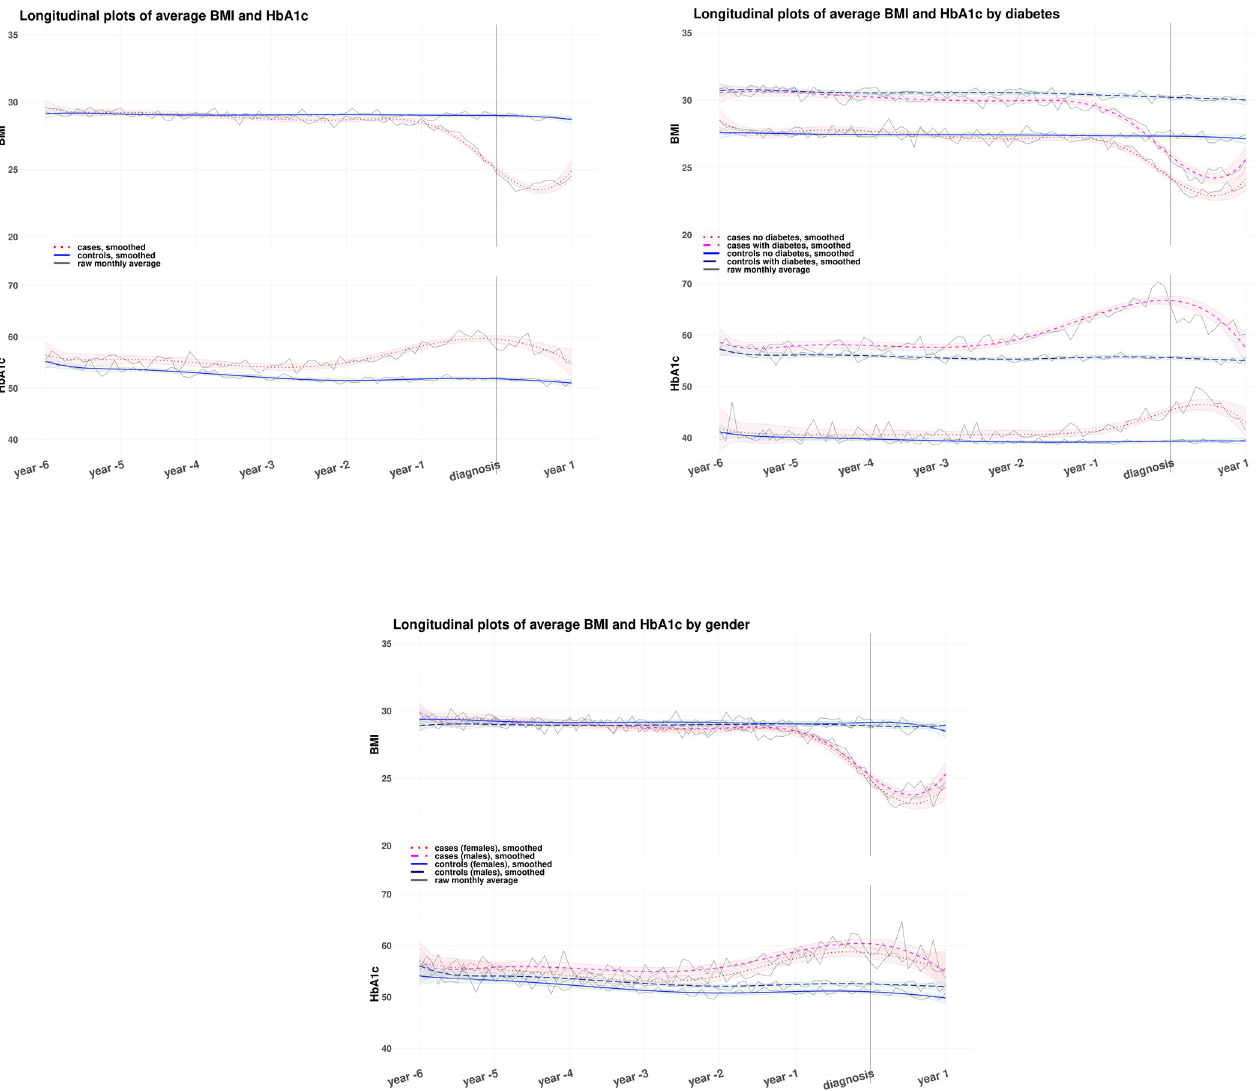
Fig 2. Longitudinal plots, BMI and HbA1c over time from six years before pancreatic cancer diagnosis up to a year after diagnosis. A) total sample, B) and C) subgroup analysis: B) by diabetes status and C) by gender. Raw monthly averages are presented with the grey continuous line. Smoothed trends over time are obtained by fitting changes in BMI and HbA1c as a function of time with linear regression and a three-knot cubic spline to allow